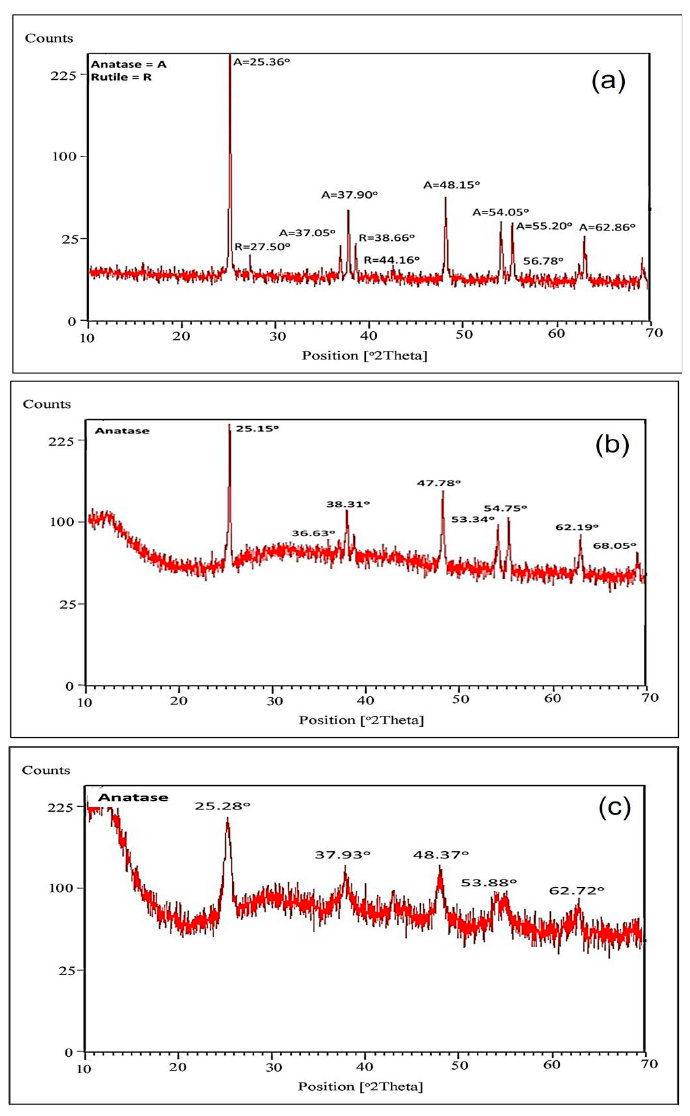
( c ) hydrothermal Figure 2. XRD image of titanium nanoparticles formed by: ( a ) Bacillus subtilis , ( b ) Cassia fistula and ( c ) hydrothermal heating.